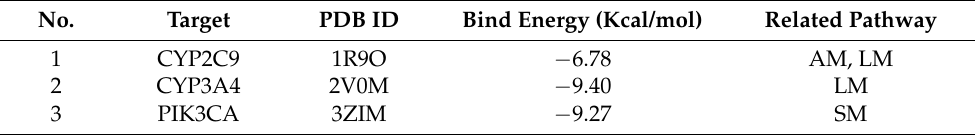
Figure 10. The 3D interaction diagrams of PPT and the key targets. Table 5. The information of key targets and